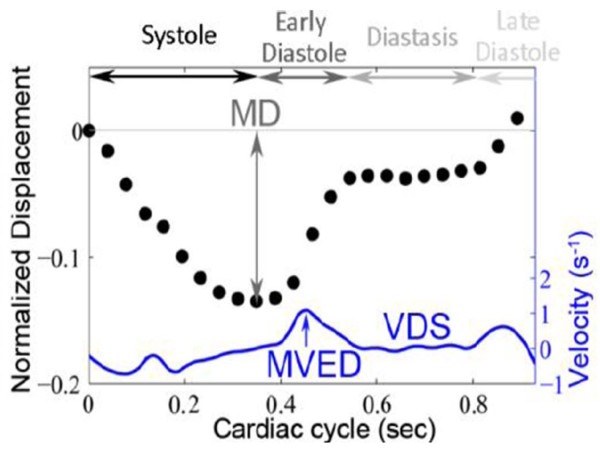
AVJ normalized velocity-versus-time plot. Derived from the AVJ normalized displacement-versus-time plot (dotted), the AVJ normalized velocity-versus-time plot (blue) shows the calculated AVJ motion variables MVED and VDS, as indicated. The motion tracking program directly calculates the MD from the AVJ normalized displacement-versus-time plot. AVJ = atrioventricular junction; MD = maximum displacement; MVED = maximum velocity early diastole; VDS = velocity diastasis.